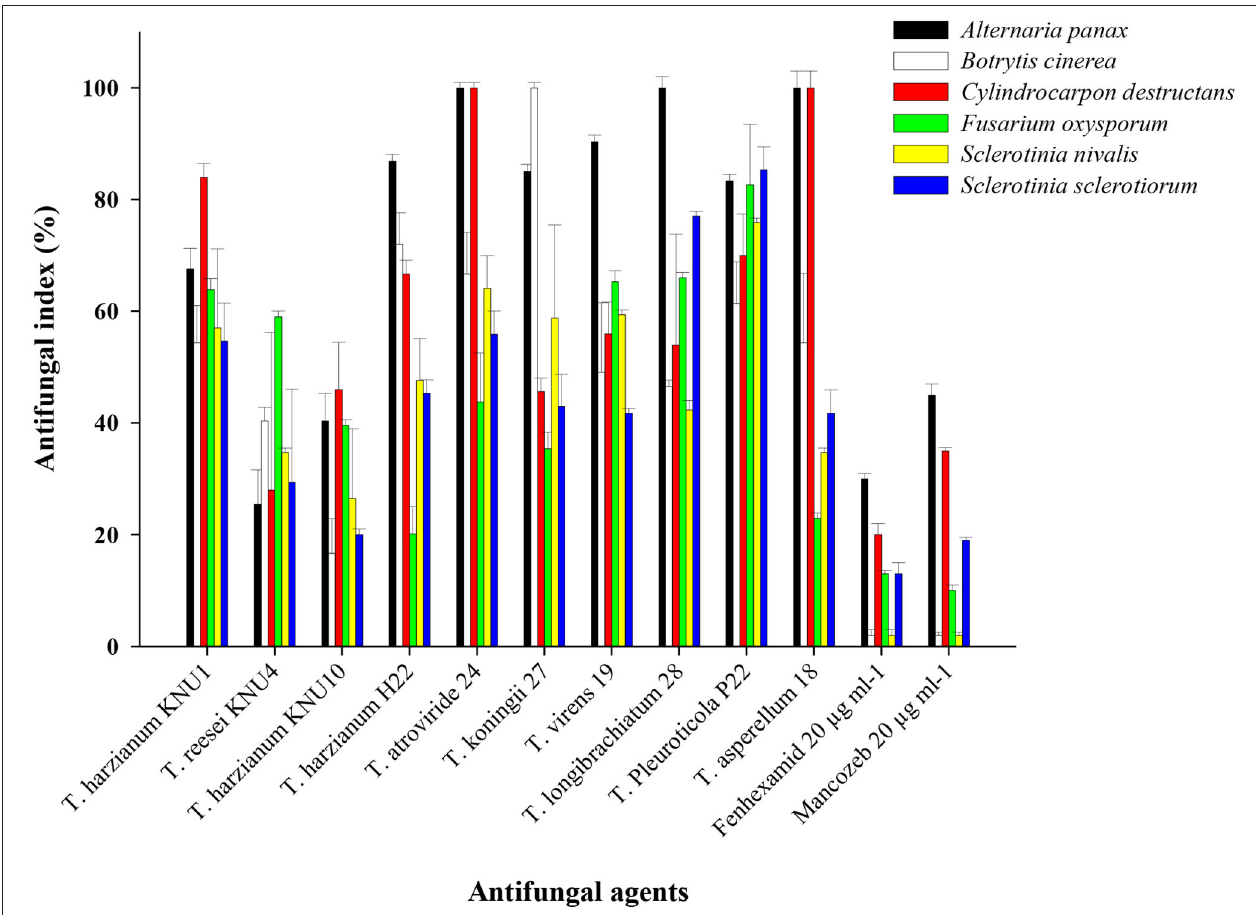
FIGURE 2 | Antifungal activity of the VOCs of Trichoderma strains against ginseng-root rot fungi in comparison to fungicides (20 µ g ml − 1 ) on B. cinerea , A. panax , C. destructans , F. oxysporum , S. sclerotiorum , and S. nivalis . The antifungal indices were detected after 10 days.